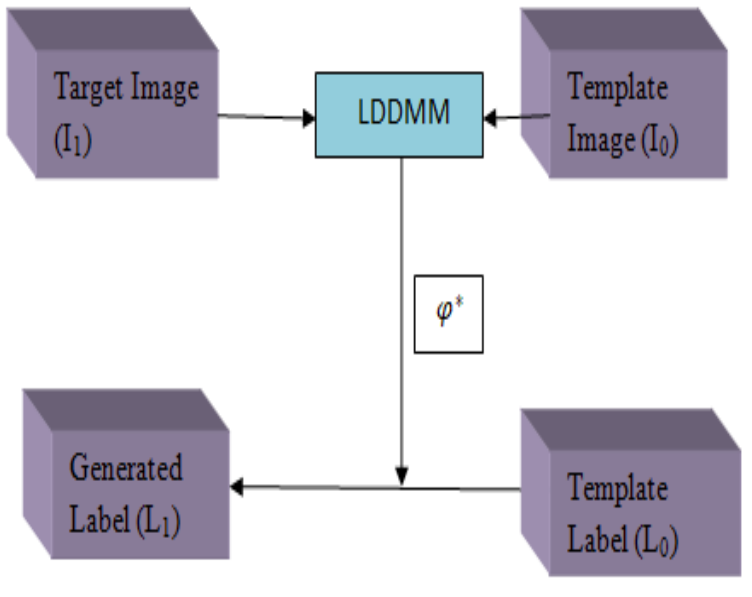
Figure 9. MI-UNET Figure 9. MI-UNET architecture.